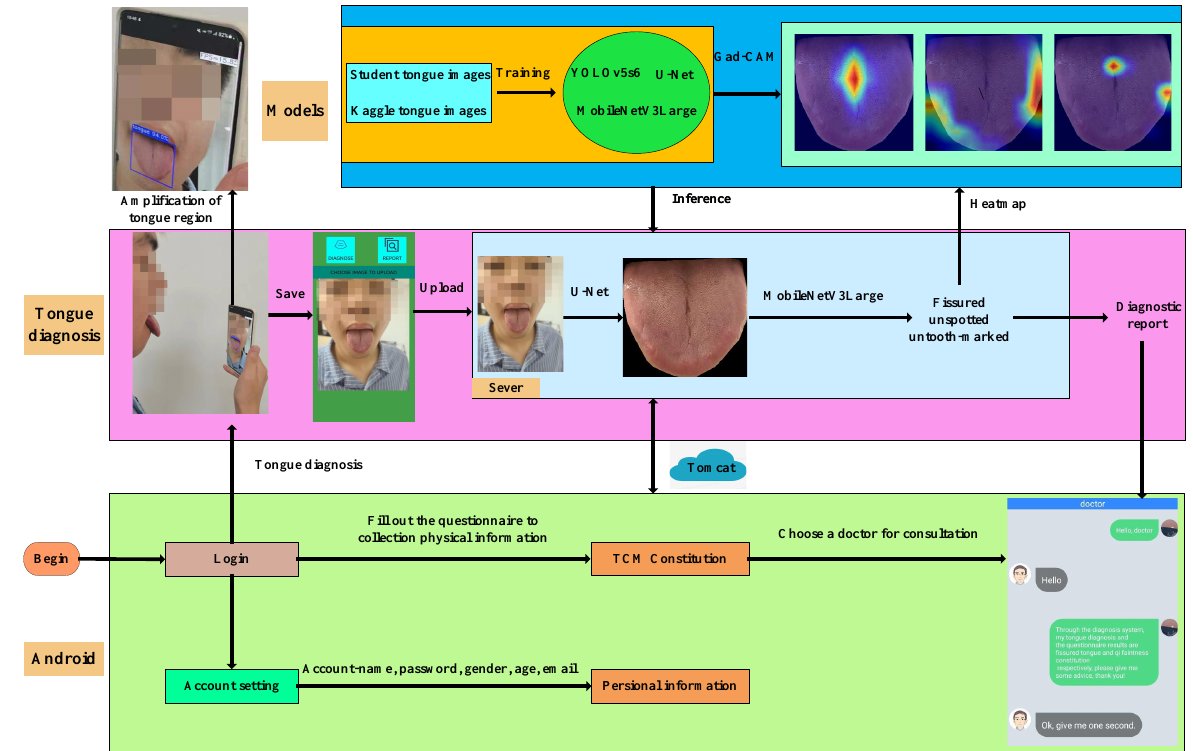
Figure 1. The architecture of the proposed tongue diagnosis